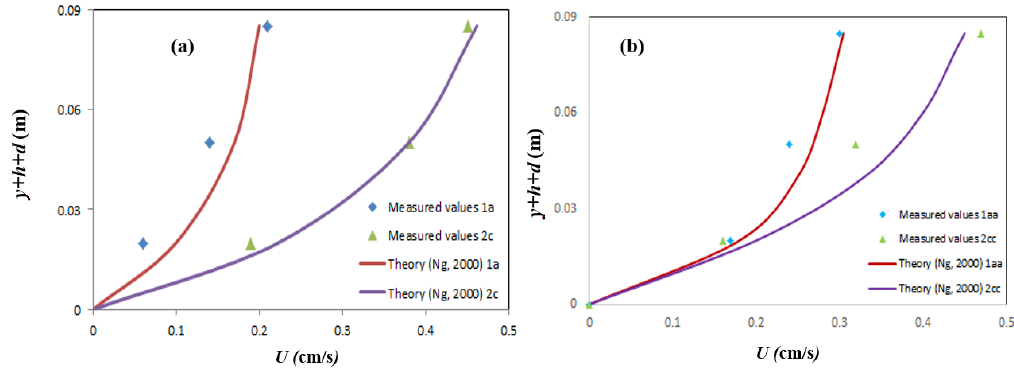
Figure 16. Comparisons between the measured mass transport rates and analytical model of Ng (2000), ( a ) H =0.04 m, and T =1.0 s (1a); H =0.07 m, T =1.1 s (2c); (b) H =0.07 m, T =1.2 s (1aa); H =0.08 m, T =1.3 s (2cc).